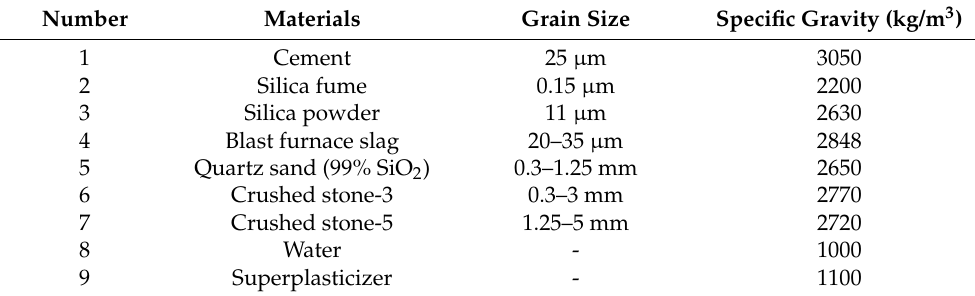
Table 1. Composition of UHPC.